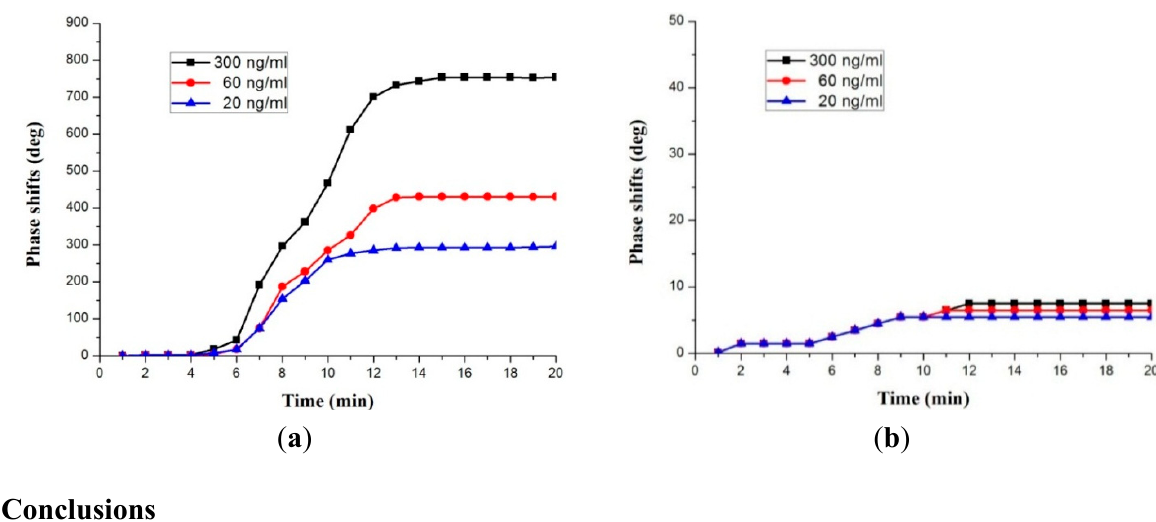
Figure 15. Phase responses of ( a ) the R3 and ( b ) R4 reflection peaks against COMP